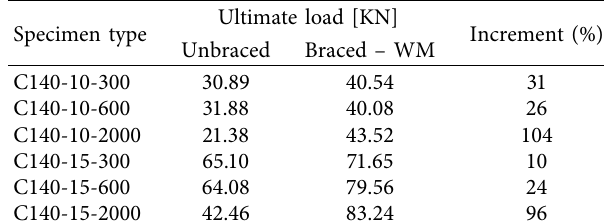
Table 2: Ultimate loads and increments of the second test series [1].